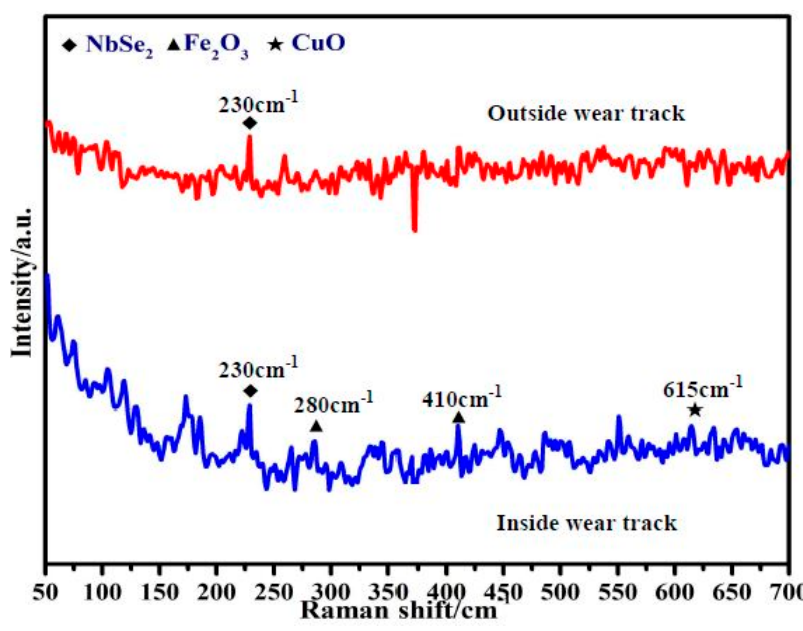
Figure 7. Raman spectrum of worn and unworn areas of specimen CNE15.